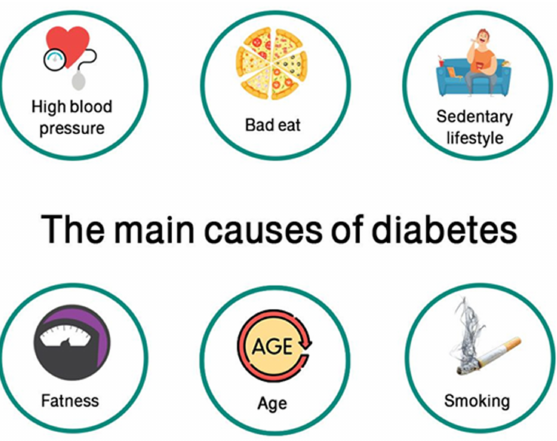
Figure 2. The main causes of